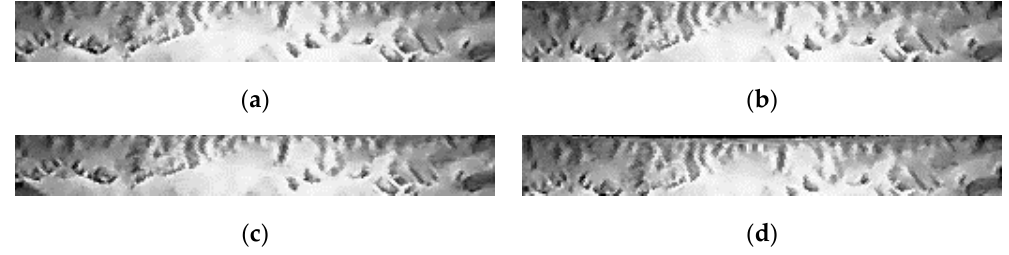
Figure 4. Steady change of constrained iris texture taken of the same person.